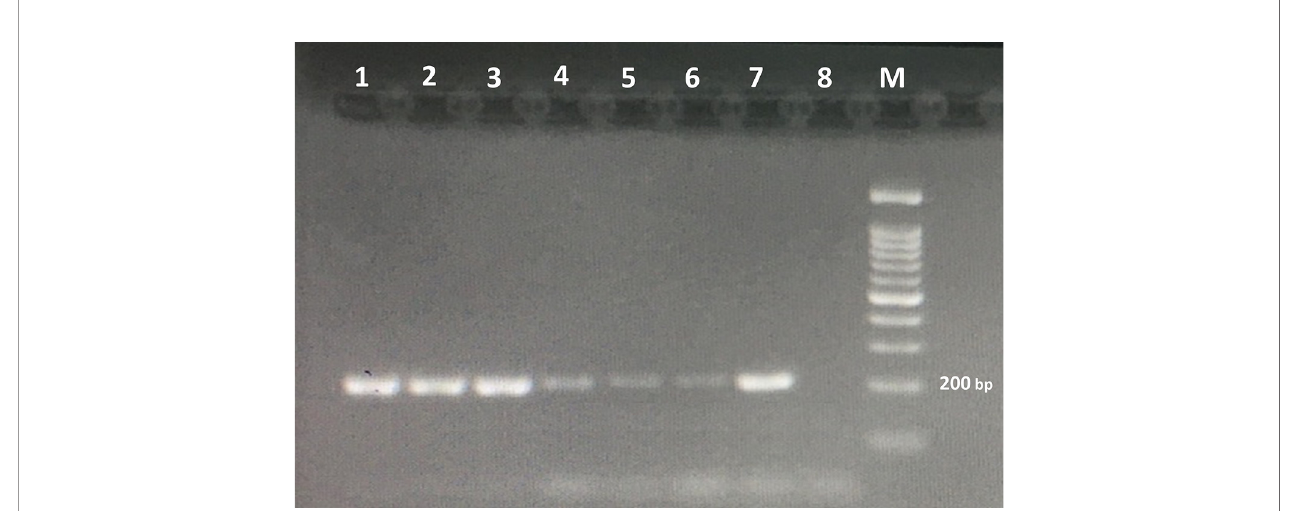
FIGURE 3 | Agarose gel electrophoresis of the PCR products ampli fi ed with genomic DNA from stool samples. The PCR products are as follows: lane 1 , DNA from 100 eggs of Trichostrongylus species; lane 2 , DNA from 50 eggs of Trichostrongylus species; lane 3 , DNA from 20 eggs of Trichostrongylus species; lane 4 , DNA from 10 eggs of Trichostrongylus species; lane 5 , DNA from 5 eggs of Trichostrongylus species; lane 6 , DNA from one egg of Trichostrongylus species; lane 7 , positive control ( Trichostrongylus colubriformis ); lane 8 : negative control. M , 100-bp DNA